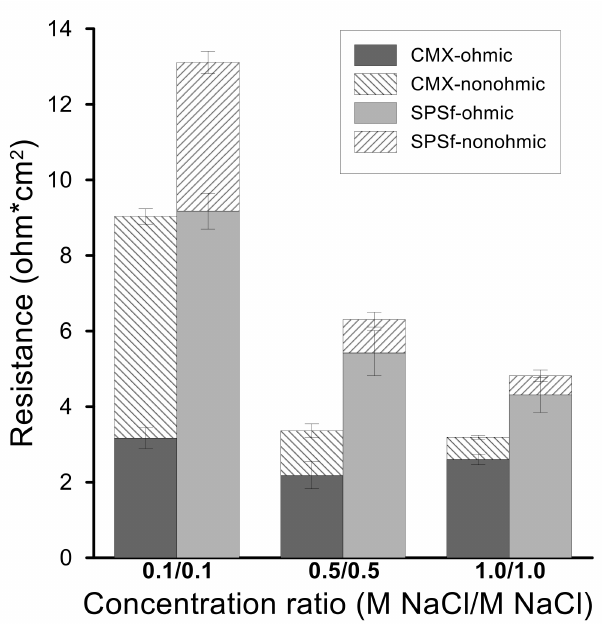
Figure 13. Resistance of CMX and sPSf at different NaCl